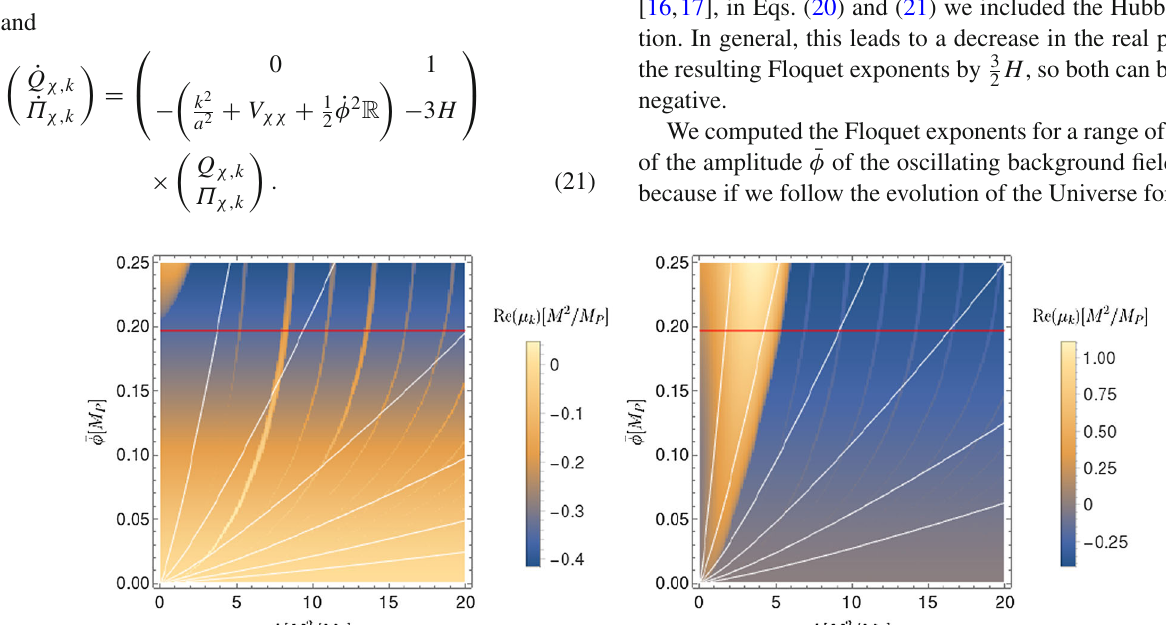
Fig. 3 Floquet exponents for the inflaton (left panel) and the spectator (right panel) perturbations with n = 3 / 2 and α = 10 −